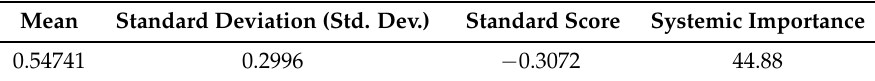
Table 1. Greece’s cross-jurisdictional activities (C-J Act.).